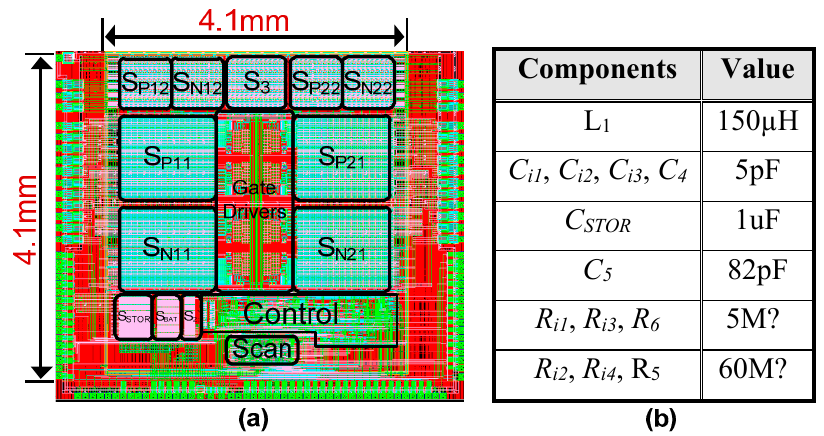
Figure 9. ( a ) Chip layout. ( b ) Components used for harvester simulations.